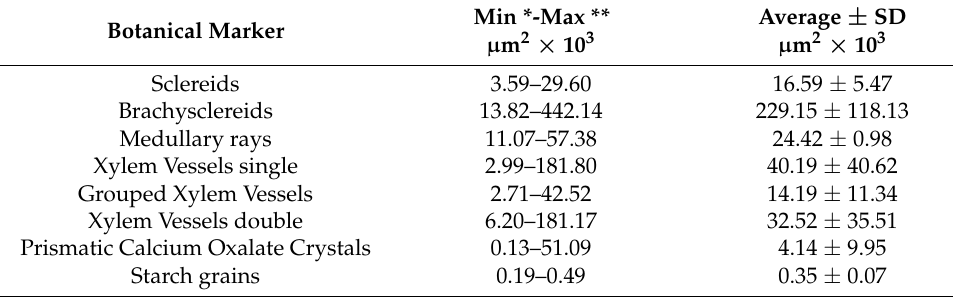
Table 2. D. villosa root micromorphological quantitative analysis.